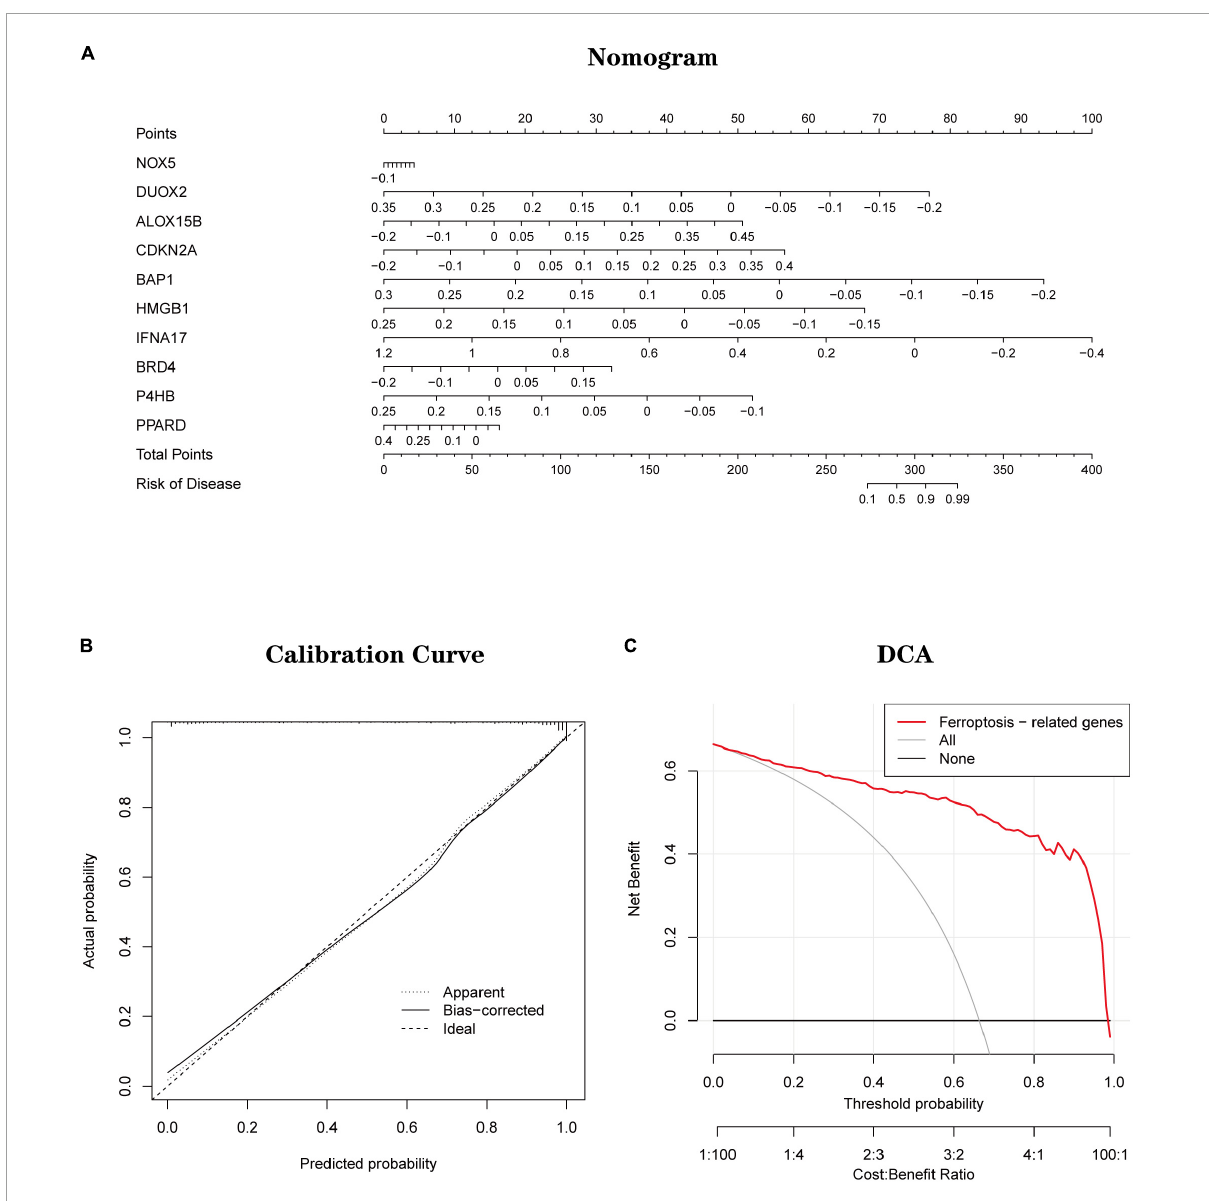
FIGURE14 (A) Establishment of a nomogram for predicting the risk of AD based on feature genes in the testing set. (B) The calibration curve evaluates the prediction efficacy of the nomogram. (C) DCA estimates the clinical benefit of the